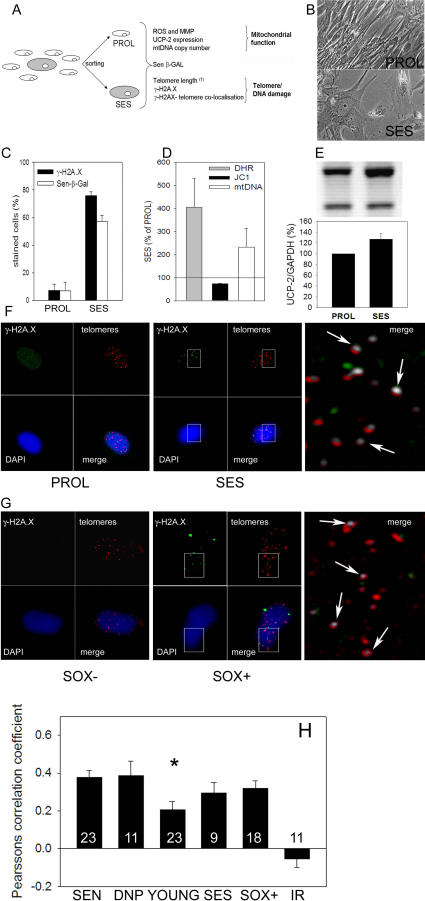
Separation of Cells with a Senescent Phenotype out of Proliferating Cultures Shows Mitochondrial Dysfunction and TIFs(A) Outline of the sorting experiments. Senescent (SES) and proliferating (PROL) cells were sorted by FACS out of growing MRC5 fibroblast cultures according to size and lipofuscin content as described [51], then replated, and the indicated parameters were measured.(B) Morphology of sorted cells 1 wk after replating.(C) Frequency of senescent cells as measured by γ-H2A.X (filled bars) or Sen-β-Gal (open bars) staining in SES- and PROL-sorted MRC5 fibroblasts. Data are mean ± s.e.m., n = 3.(D) DHR and JC-1 ratio intensities and mtDNA copy numbers in SES cells relative to those in PROL-sorted fibroblasts, mean ± s.e.m., n ≥ 3.(E) Duplex-RT-PCR of UCP-2 versus GAPDH in SES- and PROL-sorted MRC5 fibroblasts (top) and quantification of results (bottom). Data are mean ± s.e.m., n = 3.(F) Absence of γ-H2A.X staining in PROL cells and co-localisation of γ-H2A.X foci (green) with telomeres (red) in SES cells. Pixels that show significant co-localisation between foci and telomeres according to a Pearson correlation analysis are shown in white (indicated by arrows) in the magnified image on the right.(G) Absence of γ-H2A.X staining in cells sorted for low MitoSOX fluorescence intensity (SOX-) and co-localisation of foci (green) with telomeres (red) in cells with high MitoSOX fluorescence (SOX+). Magnified image on the right shows significant co-localisation as white pixels (indicated by arrows).(H) Average foci-telomere Pearson correlation coefficients for cells in senescent culture (SEN), DNP-treated senescent cells (DNP), cells that contain γ-H2A.X foci in young culture (YOUNG), SES cells, cells sorted for high MitoSOX staining intensity (SOX+), and cells 48 h after 20-Gy γ-irradiation (IR) as negative control. All conditions are significantly different from the negative control, and the asterisk (*) marks a significant difference to SEN (ANOVA). Data are mean ± s.e.m., with the number of cells evaluated given for each condition.